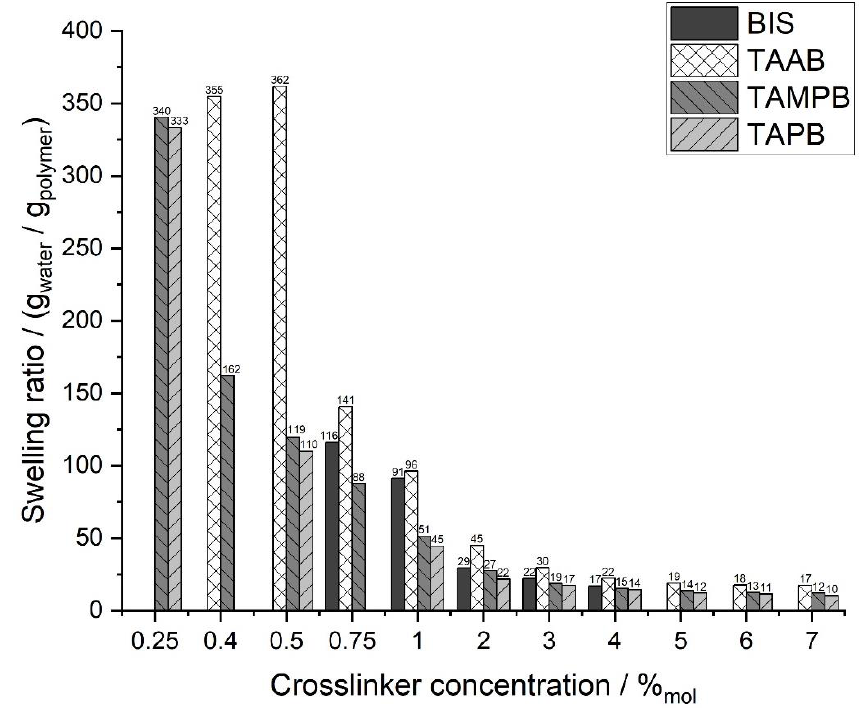
Figure 7. Swelling ratios of cationic poly(DADMAC) gels with different cross-linkers as a function of the cross-linker concentration. Reproducibility is approx. ± 5 % for values <200g/g and approx. ±14 % above that.